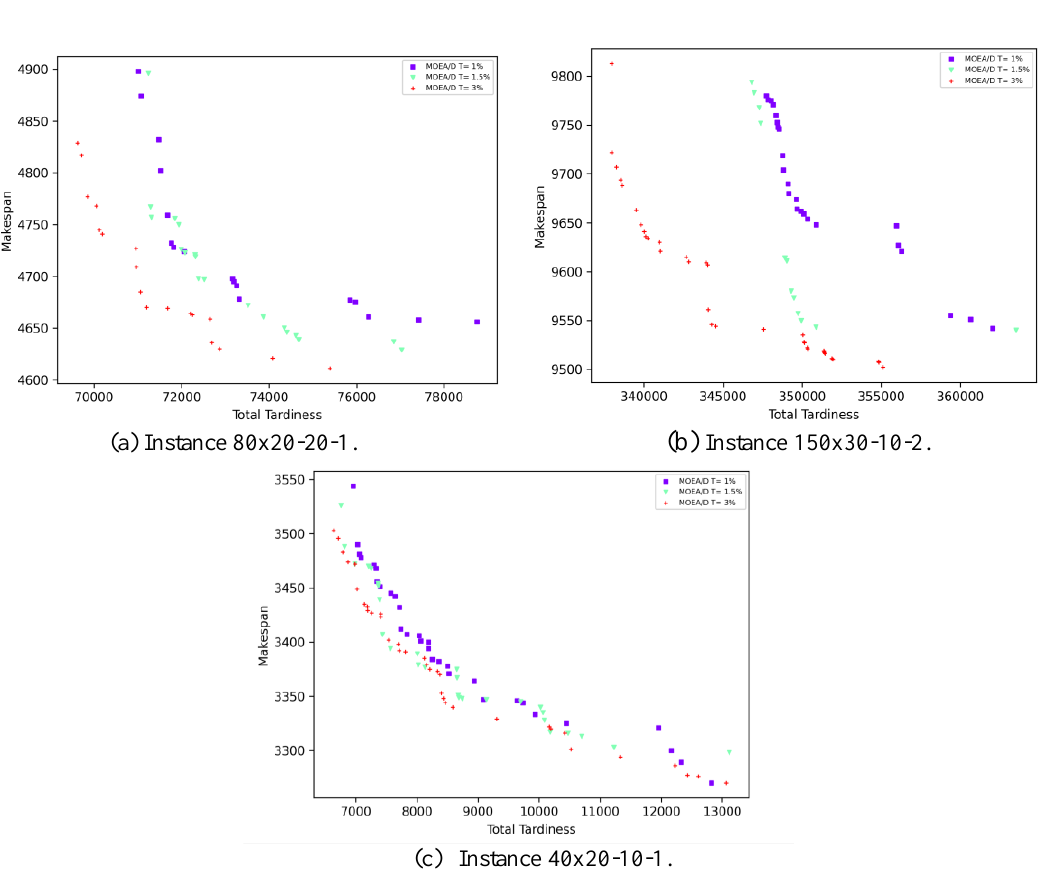
Figure 3 . Pareto fronts of MOEA/Ds for representative problem